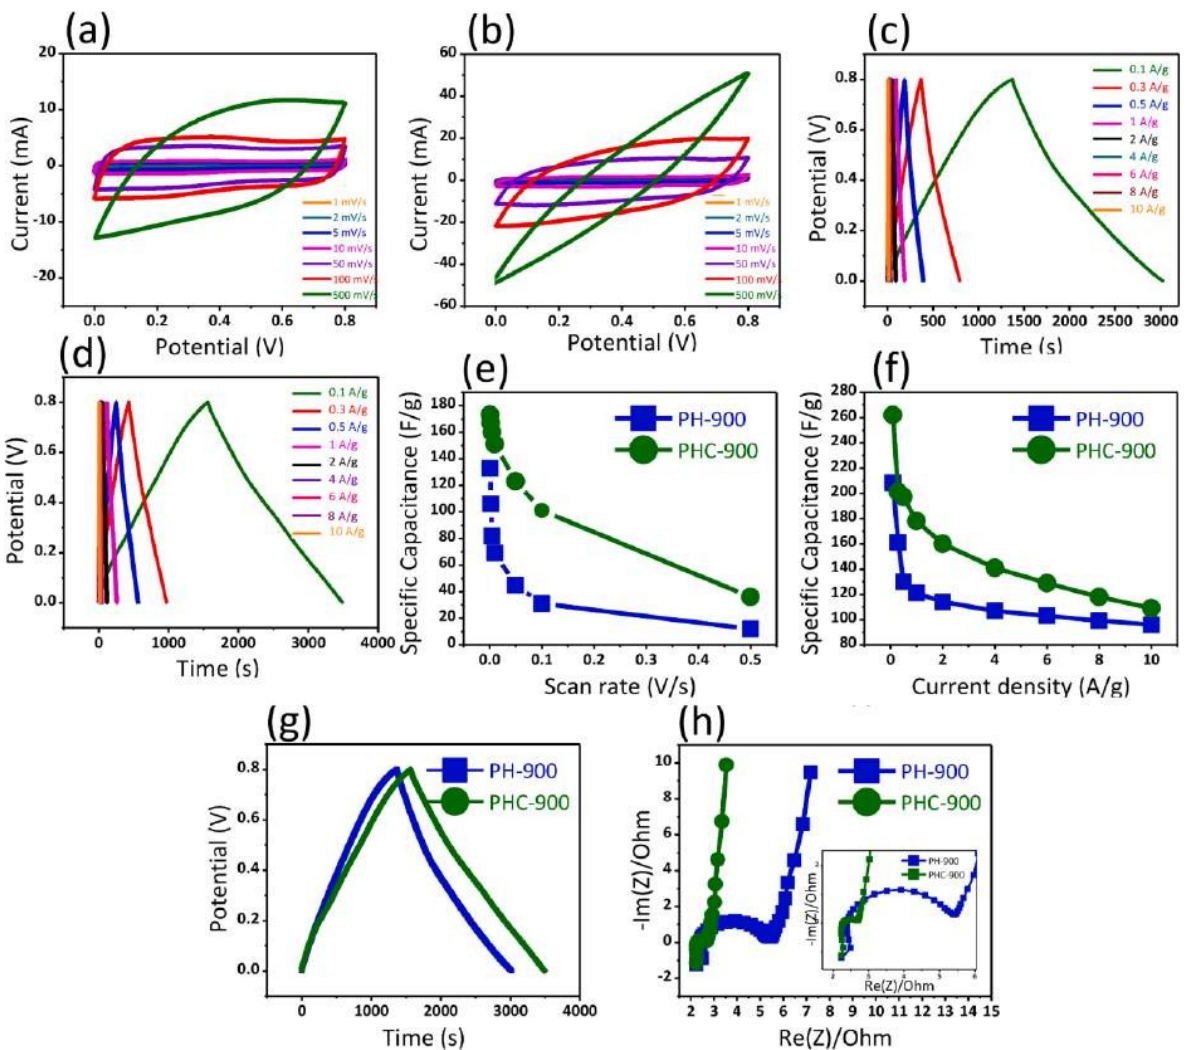
Figure 30. CV results of ( a ) PH-900 ( b ) PHC-900, GCD results of ( c ) PH-900 ( d ) PHC-900 ( e ) scan rate dependent specific capacitance and ( f ) current density dependant specific capacitance ( g ) comparison of GCD curves at 0.1 A/g current density ( h ) EIS spectra (inset at high resolution at the higher frequency range). Reproduced with permission from [114].